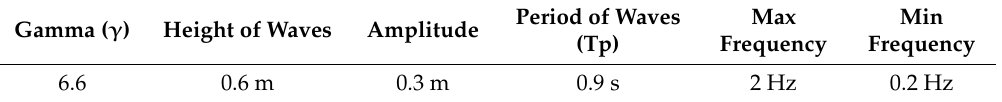
Table 2. JONSWAP simulation parameters.